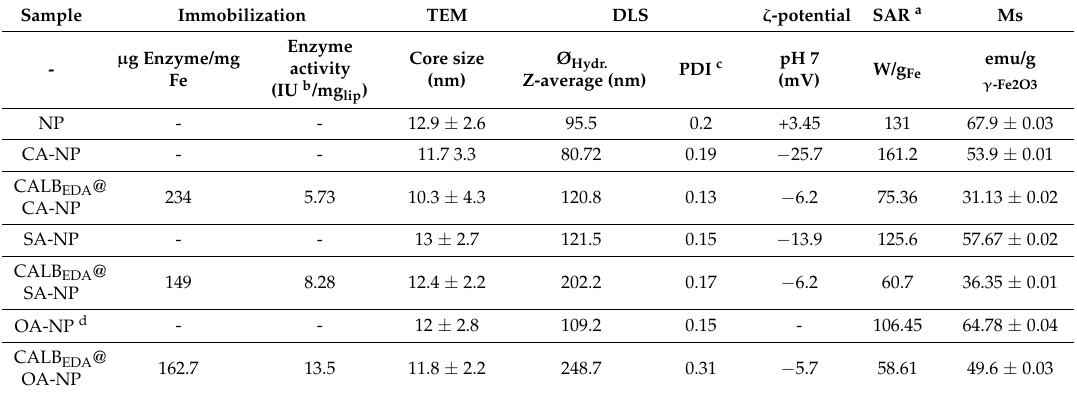
Table 1. Physical, chemical and magnetic characterization of citric acid (CA), succinic anhydride (SA) and oleic acid (OA) coated nanoparticles (NPs) with or without aminated CALB immobilized on their surfaces.